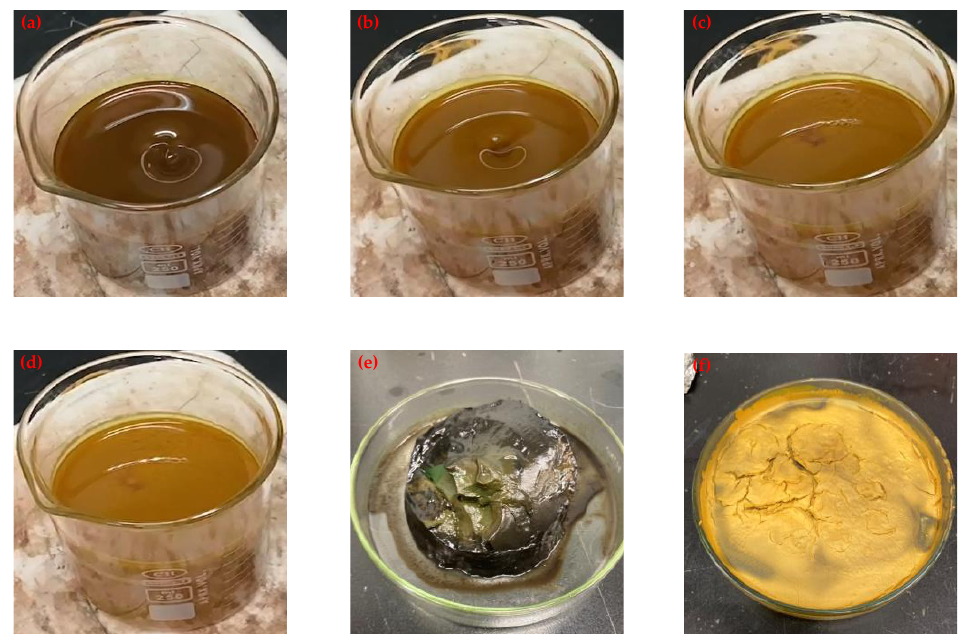
Figure 1. Polymerization mixture of Co-PAM. ( a ) Initial, ( b ) 10 min, ( c ) 20 min, ( d ) 30 min, ( e ) after evaporation of alcohol, ( f ) dry PAM cake prepared without CoCl 2 .